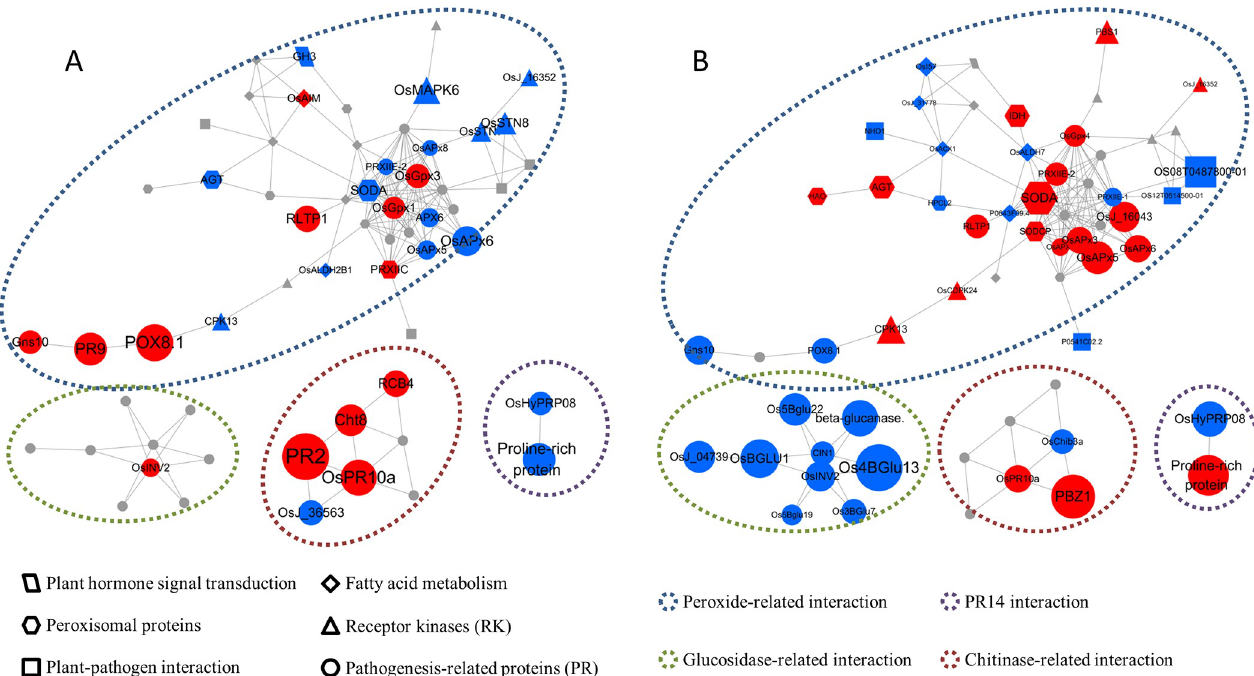
Fig 4. Interaction network of crucial DEPs in GY8 and LTH. A: Interaction network of DEPs in GY8; B: Interaction network of DEPs in LTH. The color of spot represents the expression pattern. Red represents up-regulated, blue represents down-regulated and gray represents unchanged. The size of spot represents the fold-change, the bigger the size, the higher the fold-change. The shape represents the family or pathway of the protein. Four main clusters were circled by broken Line with different color.